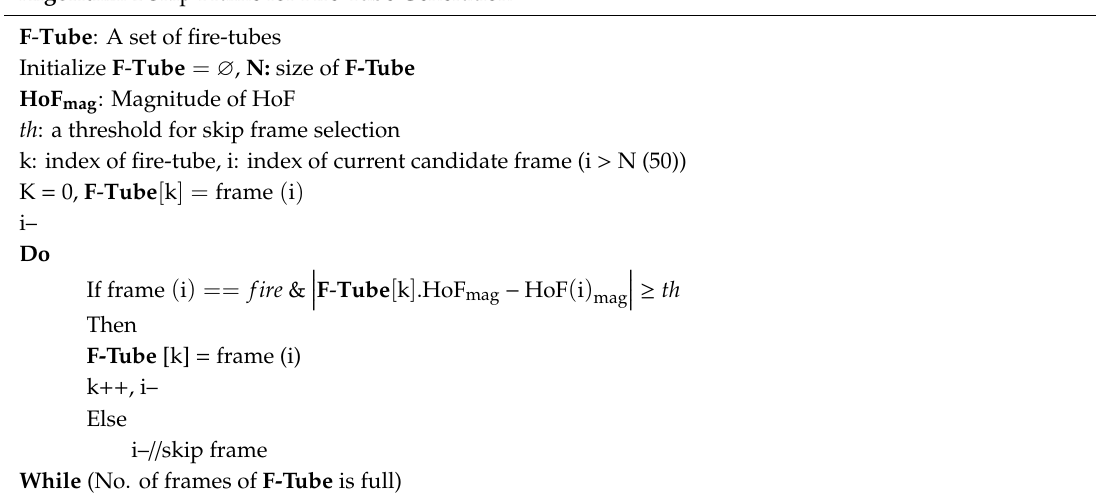
Algorithm 1 Skip Frame for Fire-Tube Generation F - Tube : A set of